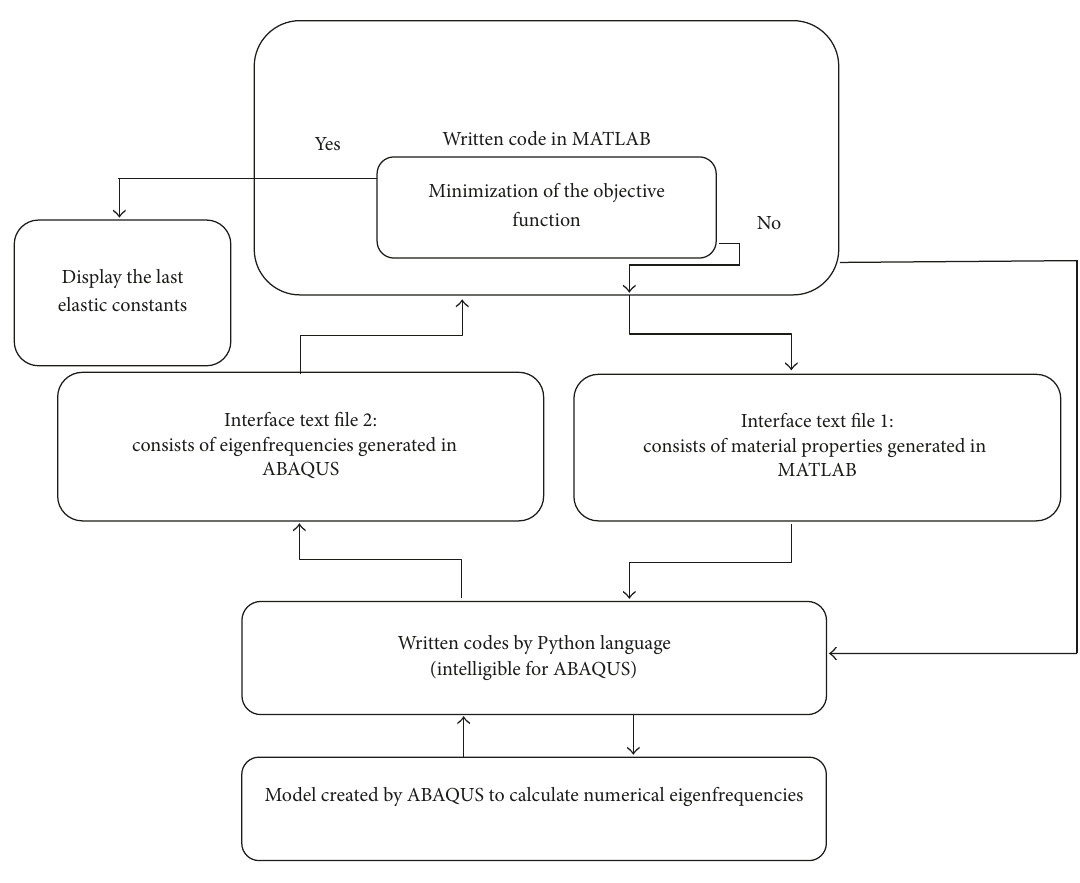
Figure 1: Flowchart of the CPAM inverse solver